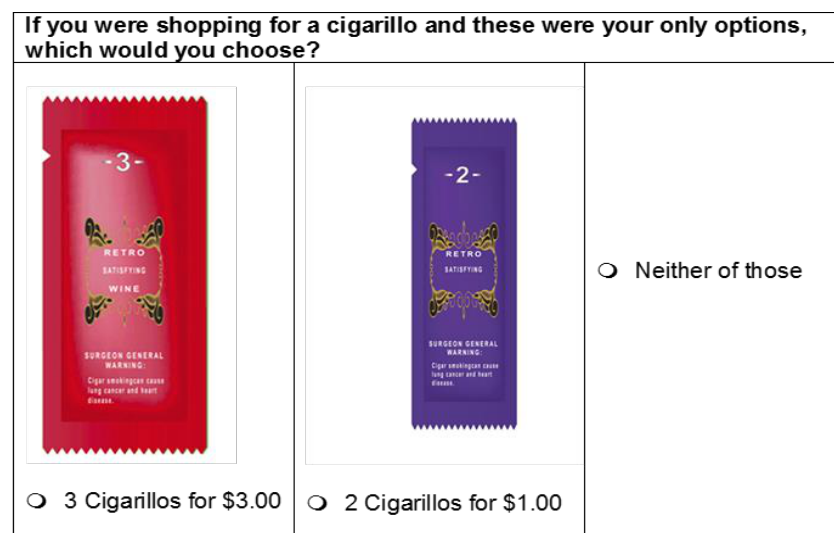
Figure 2. Sample choice set with hypothetical flavored cigarillo packages.